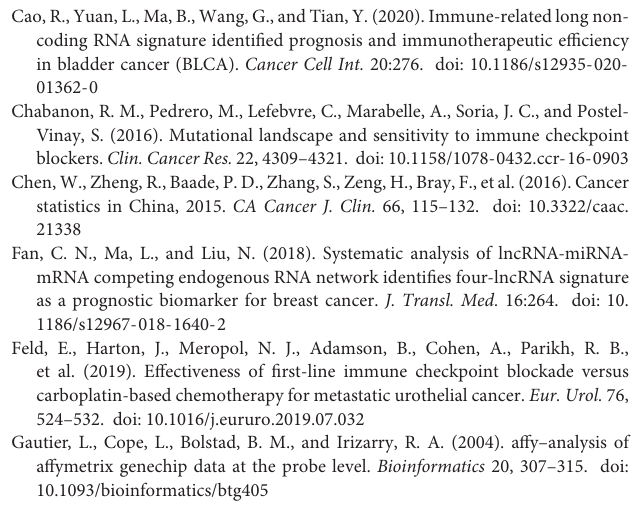
Supplementary Figure 1 | The heart map displayed the differential expression of specific signaling pathway related genes. Supplementary File 1 | The raw data of ESTIMATE algorithm scores. Supplementary File 2 | The raw data of TME scores. Supplementary File 3 | The raw data of immune cell infiltration CIBERSORT algorithm scores. Supplementary File 4 | The raw data of immune checkpoint inhibitor response (TIDE)